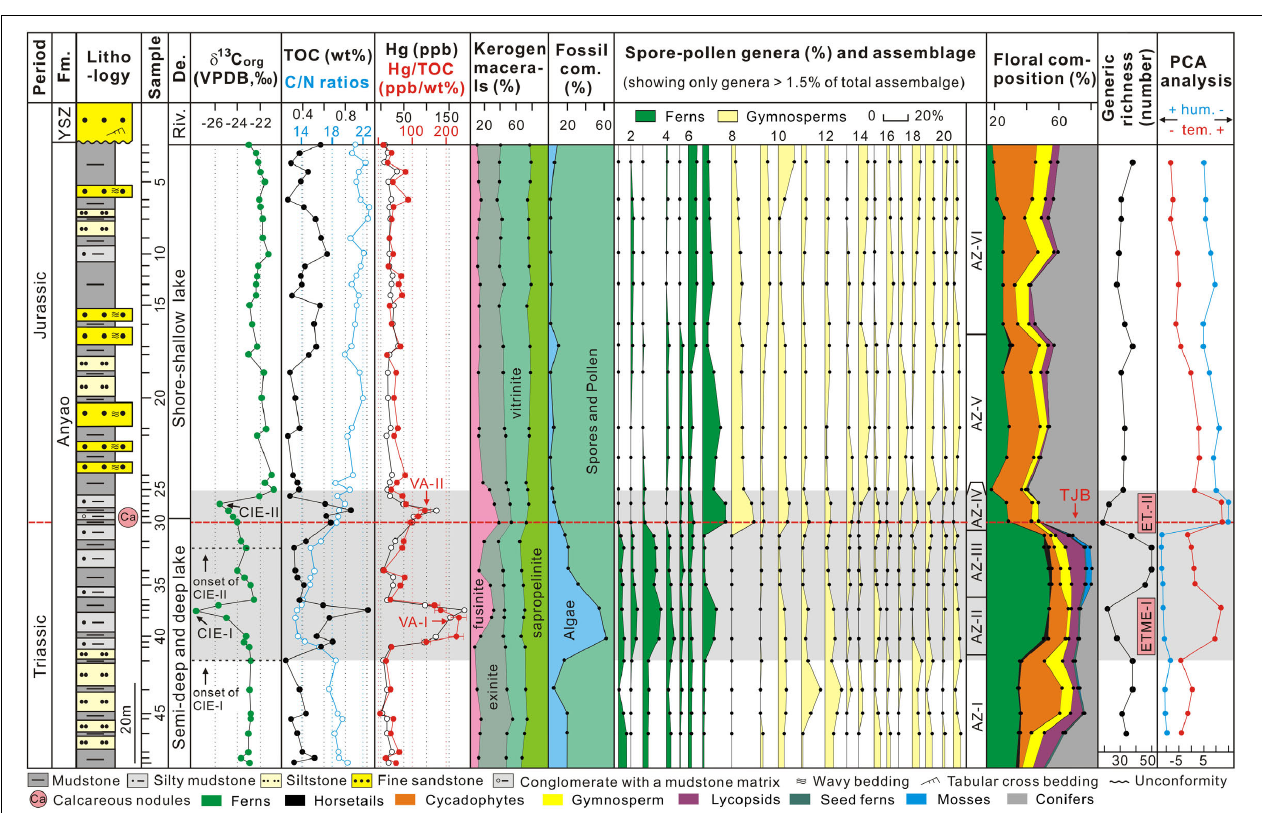
FIGURE 2 | Results of δ 13 C org values, TOC contents, C/N ratios, Hg concentrations, Hg/TOC ratios, kerogen macerals, fossil component, spore-pollen genera and palynology assemblage, floral composition, generic richness (number of different genera, excluding rework taxa), and principal components analysis (PCA) from the studied borehole in the Jiyuan Basin. Note that error bars on Hg/TOC plots represent the propagated error on Hg ( ± 5%) and TOC ( ± 0.2%) content measurements, and spore-pollen species more than 1.5% are plotted (more detailed data are shown in Supplementary Table 1 ). Fm., Formation; YSZ, Yangshuzhuang; De., Depositional environment; Riv., River; VPDB, Vienna Pee Dee Belemnite; CIE-I to CIE-II, from the first organic carbon isotope excursion to the second organic carbon isotope excursion; VA-I, first pulse of volcanic activity; VA-II, second pulse of volcanic activity; floral com., floral composition; 1, Crassispora (reworked); 2,